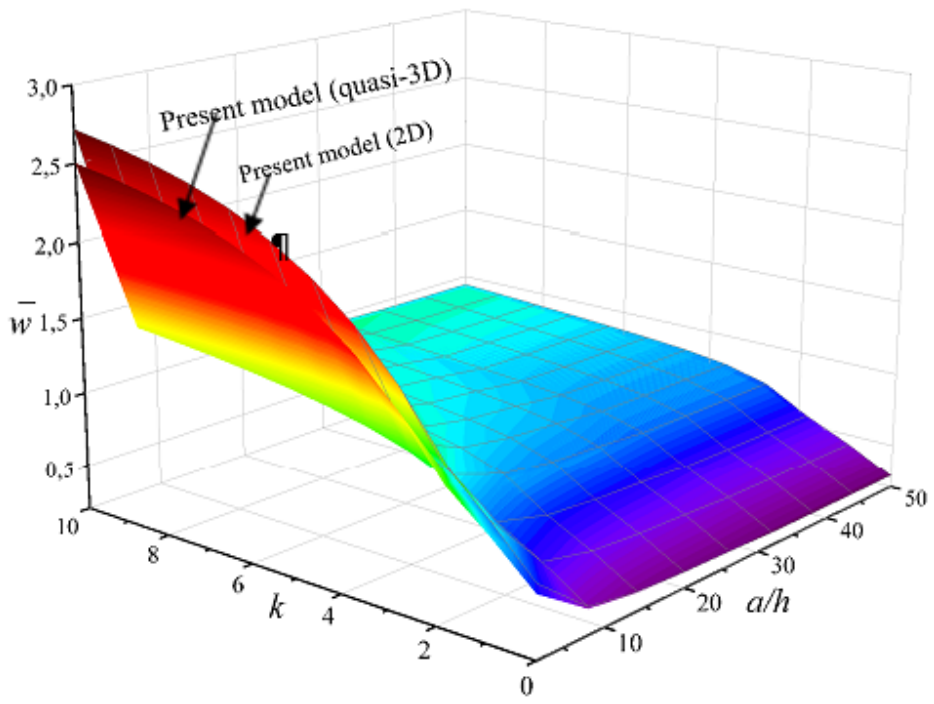
Figure 3. Effect of the power law index k and side-to-thickness ratio a / h on the non-dimensional deflection w of simply supported Al / Al 2 O 3 P − FGM